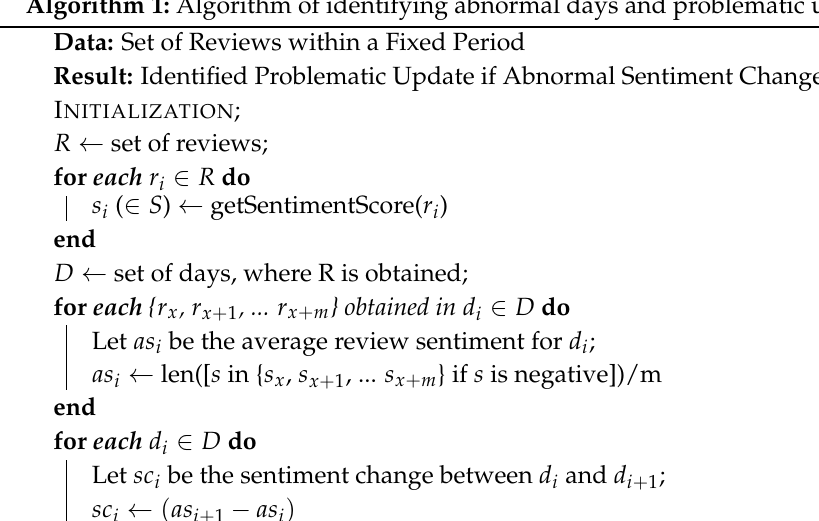
Algorithm 1: Algorithm of identifying abnormal days and problematic updates. Data: Set of Reviews within a Fixed